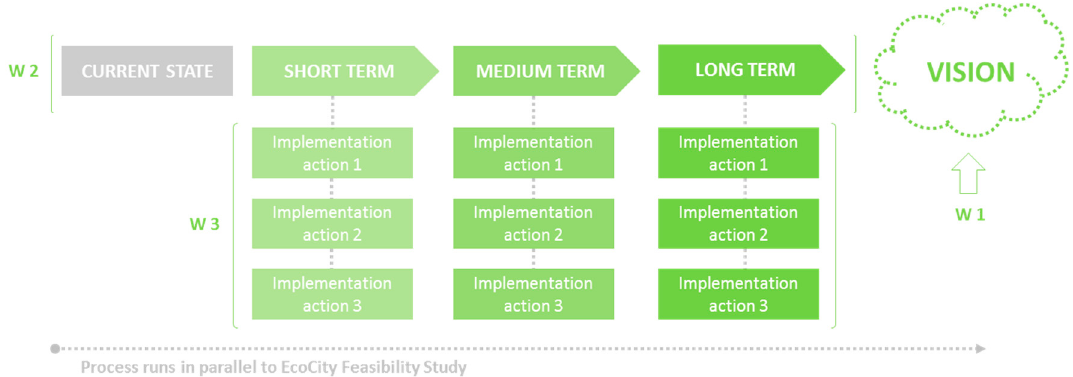
Figure 1. Simplified conceptual outline of a roadmap adapted from [21,22]. The development of the roadmap starts from defining the vision in workshop 1 (W1). Then thematic roadmaps for reaching the vision are crafted in workshop 2 (W2). Finally, detailed implementation actions are outlined in workshop 3 (W3).